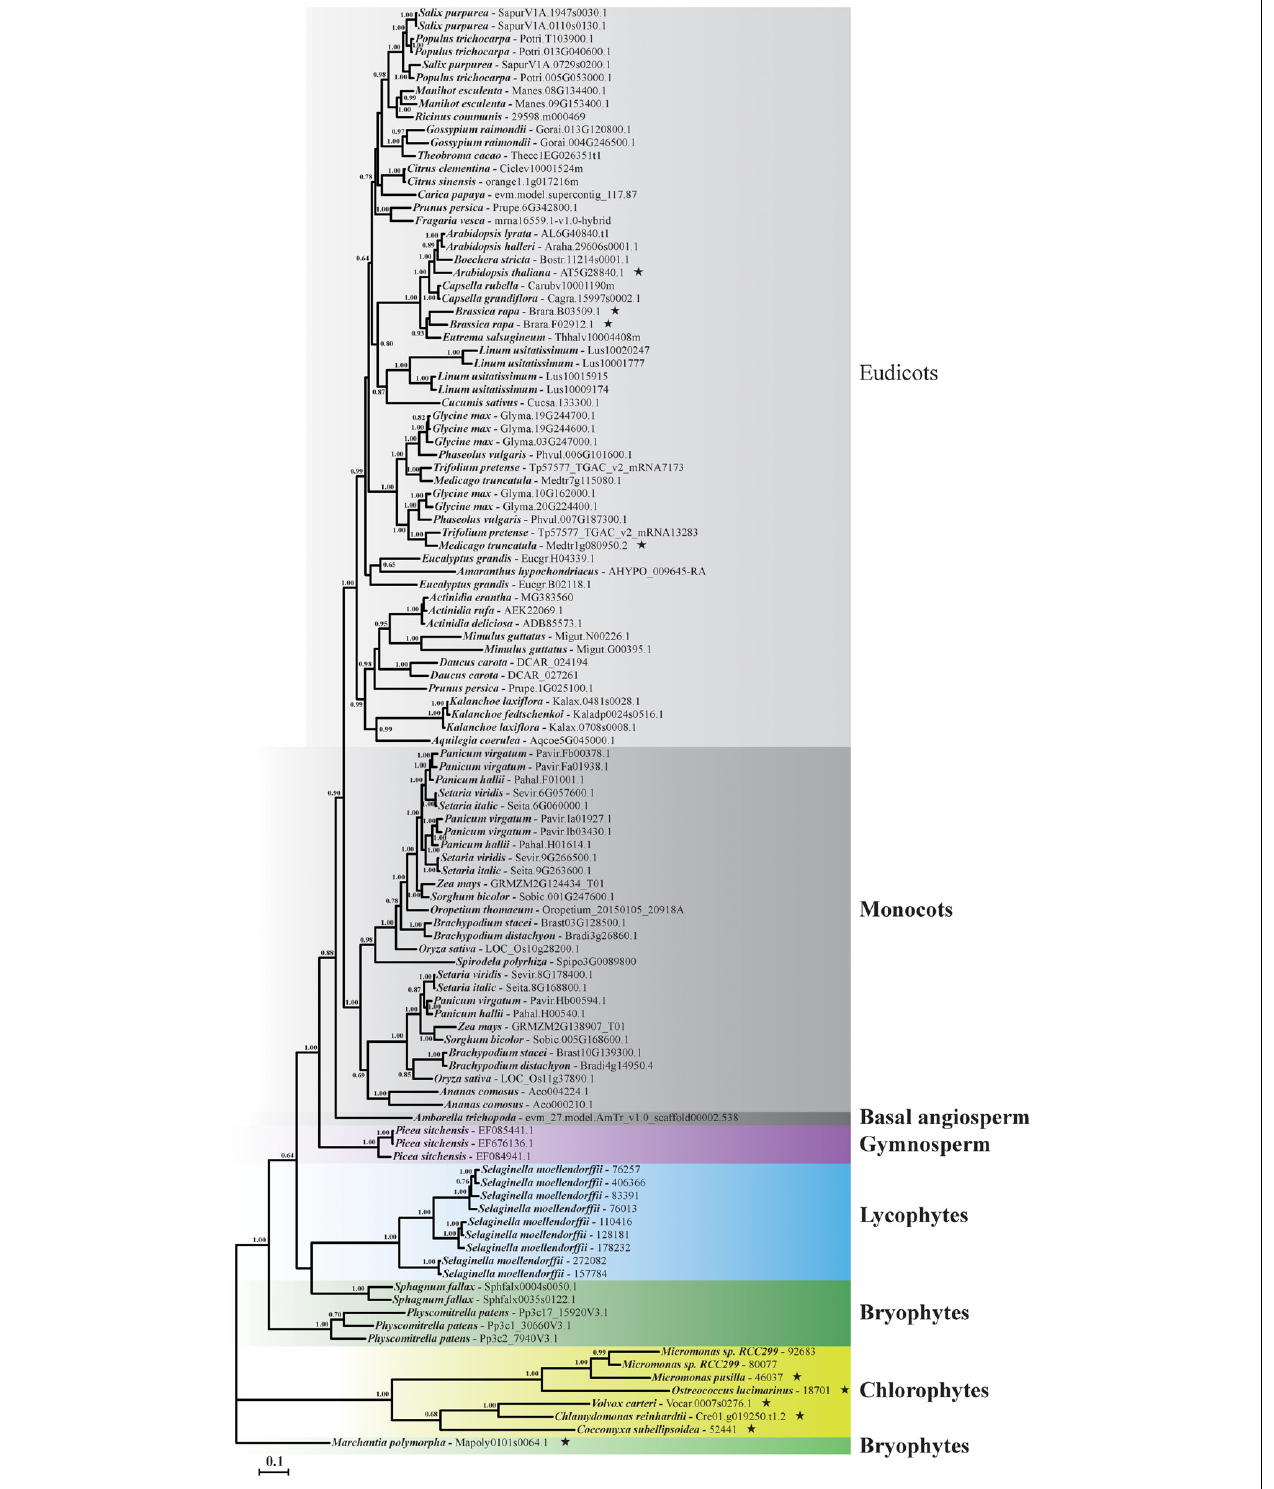
FIGURE 2 | Phylogenetic relationships of GME gene in Viridiplantae. The phylogenetic tree of plant GMEs was constructed by the Bayesian analyses method based on the best fitted nucleotide substitution model of GTR+I+G. Posterior probabilities above 0.6 were labeled near the nodes. Accession number of each GME sequence was listed behind the species name. Branches identified under episodic diversifying selection by branch-site model were labeled using asterisk marks ( (cid:70) ).